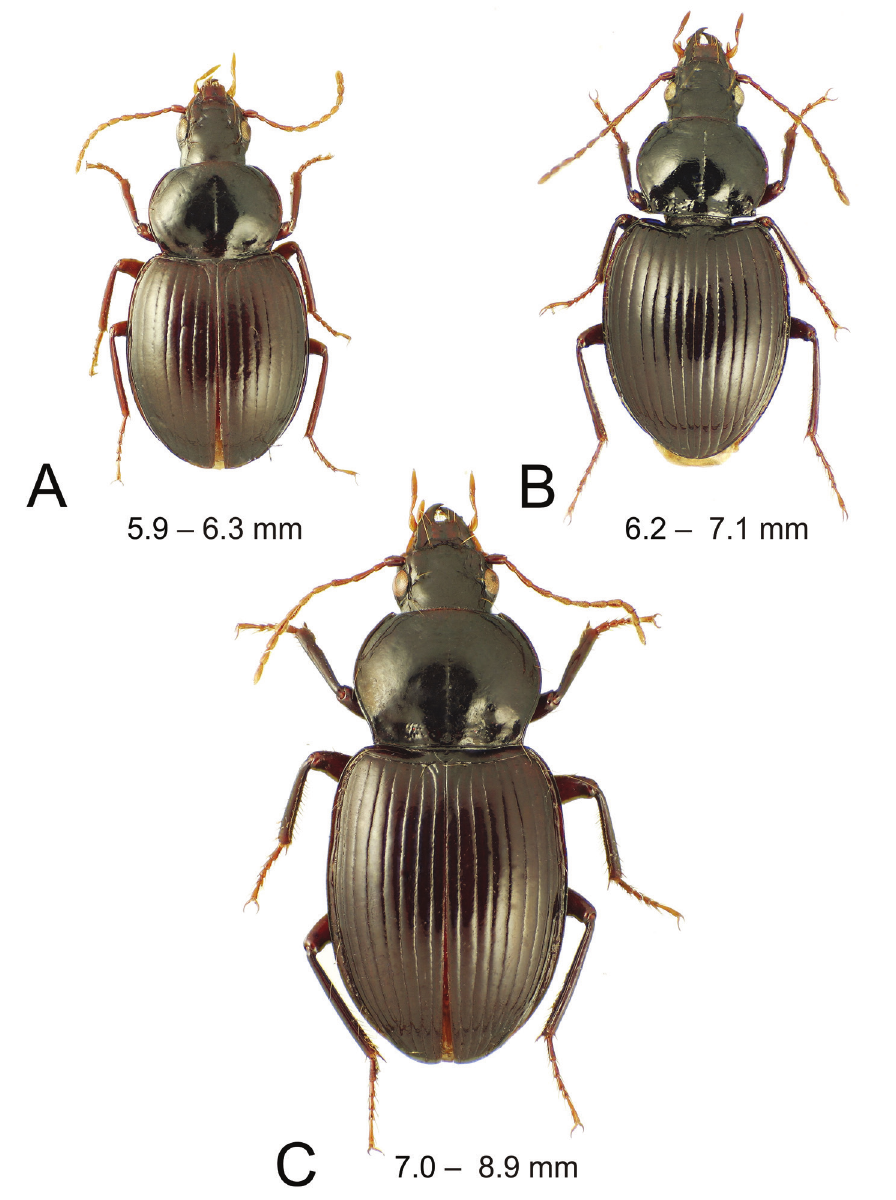
Figure 1. Dorsal habitus illustrations of Theprisa spp.; range of standardized body lengths indicated A T. otway female B T. convexa female C T. montana female. horizontal line; ligula slightly convex apically, narrowed basally, trumpet shaped, its two apical setae separated by three setal diameters; paraglossae elongate, total length 2.5× distance from paraglossal base to ligular apical margin. Pronotum